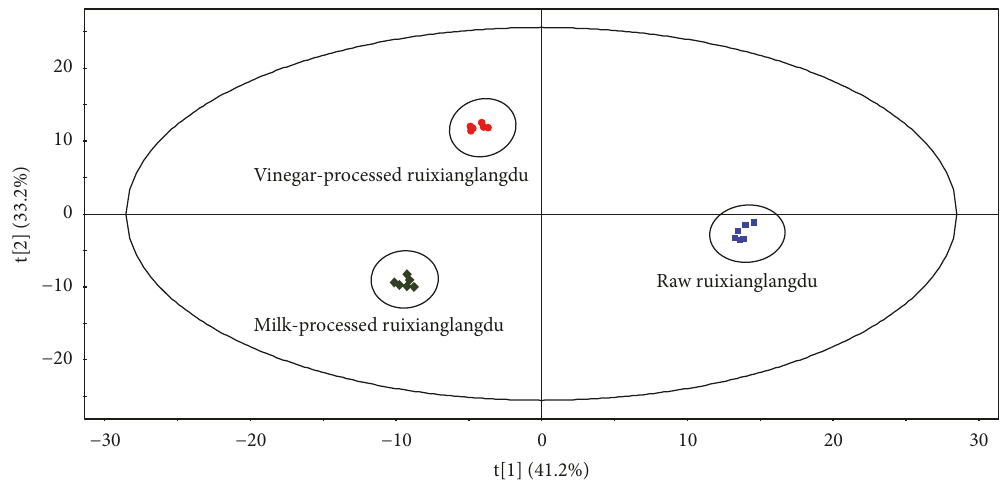
Figure 2: Principle component analysis scores plot for ruixianglangdu and its processed